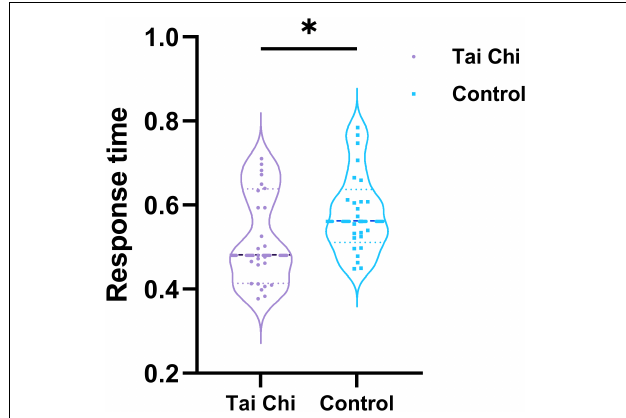
FIGURE 2 | Reaction time of TC group and control group under auditory “Oddball” experiment. ∗ Indicated significant difference between groups, p < 0.05.